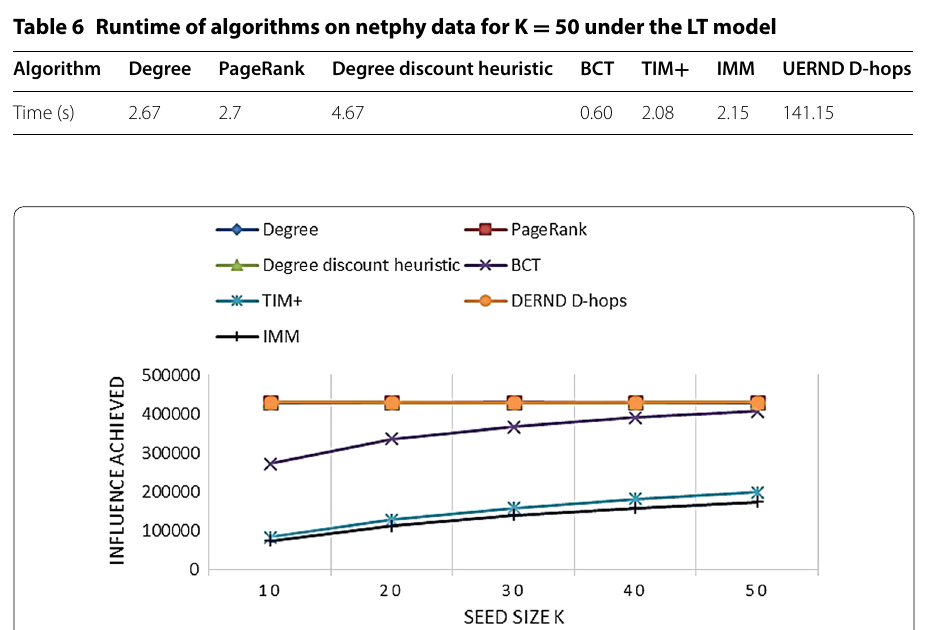
Fig. 5 Influence coverage of our algorithm under the IC model on Twitter data. Degree PageRank Degree discount heuristic BCT TIM